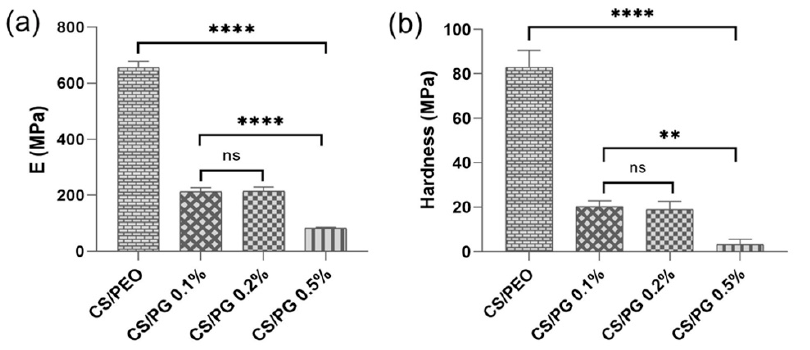
Figure 5. Nano-mechanical characteristics expressed by ( a ) Young’s modulus and ( b ) hardness of investigated nanofibrous structures; ns p > 0.5, ** p < 0.005, **** p < 0.0001.